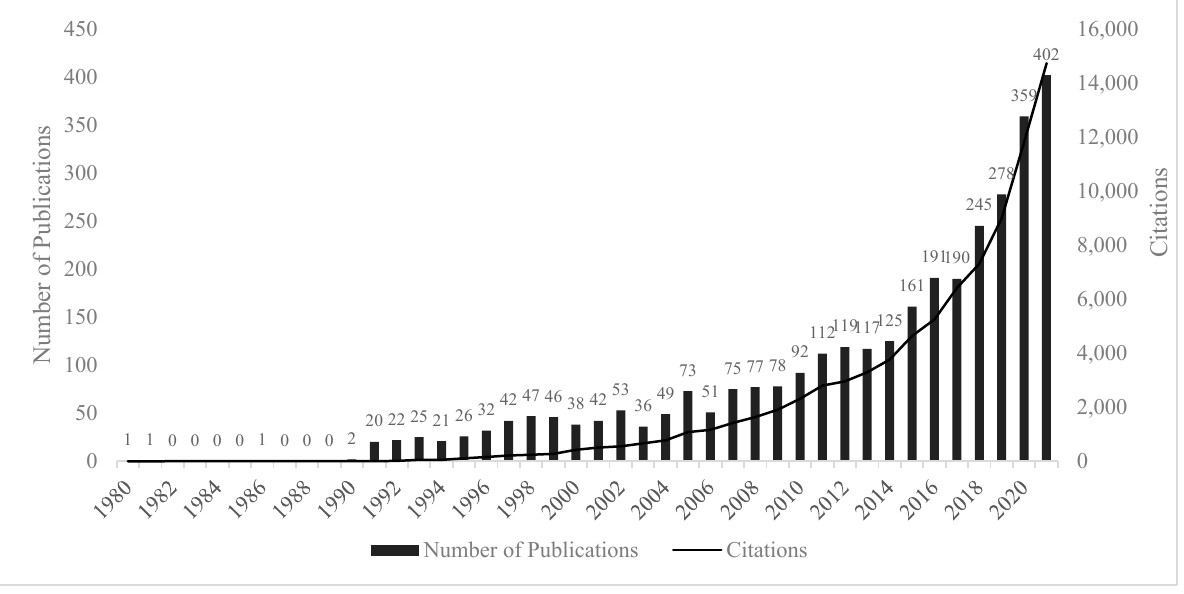
Figure 2. The basic descriptive of publications from 1980 to 2021.